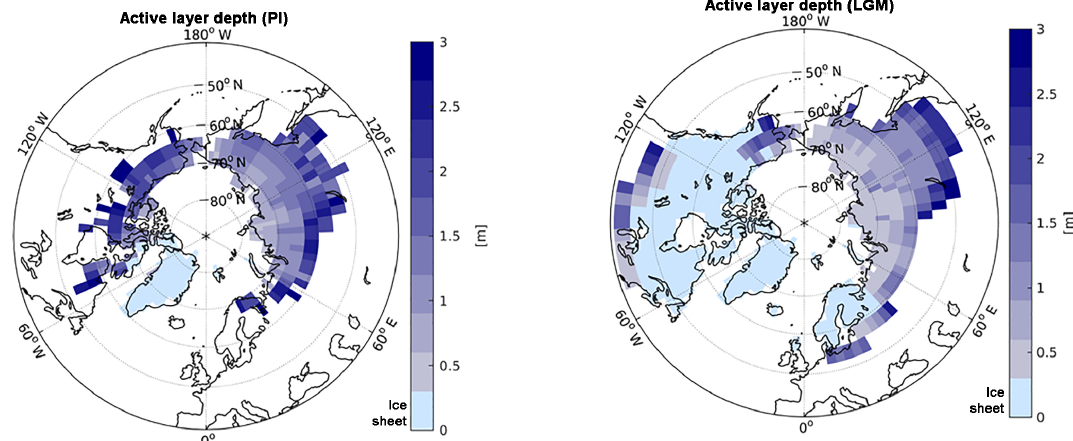
Figure 3. Active layer depths (ALDs) in near-surface permafrost soils at PI and LGM simulated by JSBACH. Light bluish-coloured areas show prescribed ice sheet coverage. Data shown represent 100-year time averages.